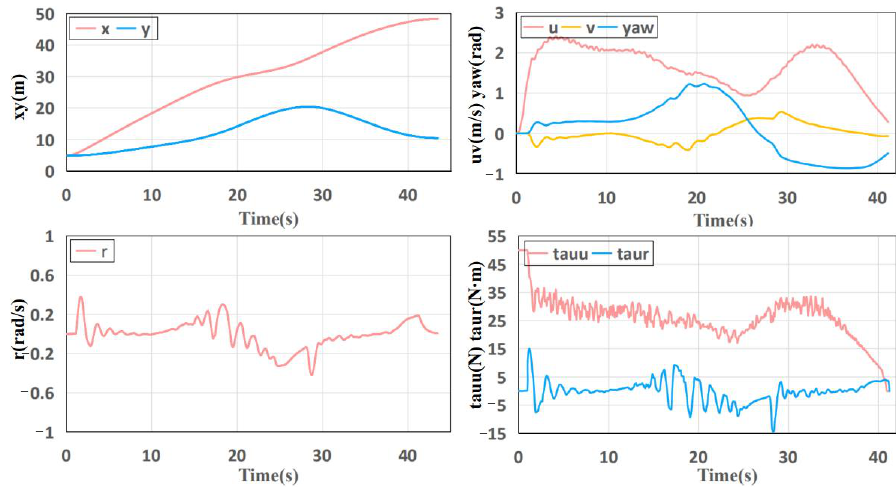
Figure 6. The changing trend of the state and control quantity of the USV with time.